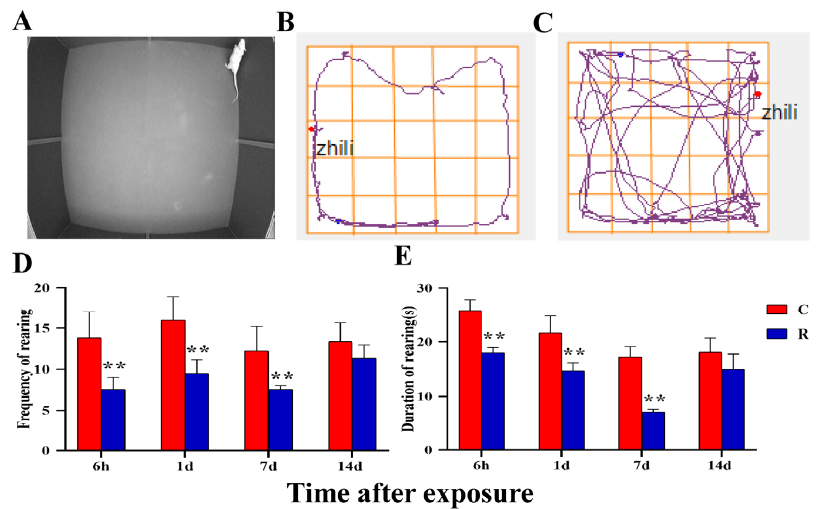
Figure 12. Changes noted during the open field experiment of rats after S-band radiation-upright behavior. ( A ) The real shot of the rat when upright; ( B ) the trajectory diagram of the Group R; ( C ) the trajectory diagram of the Group C; ( D ) statistical analysis graph of frequency of upright behavior; ( E ) statistical analysis graph of duration of upright behavior. Significance signs were classified according to p -value: ** p <